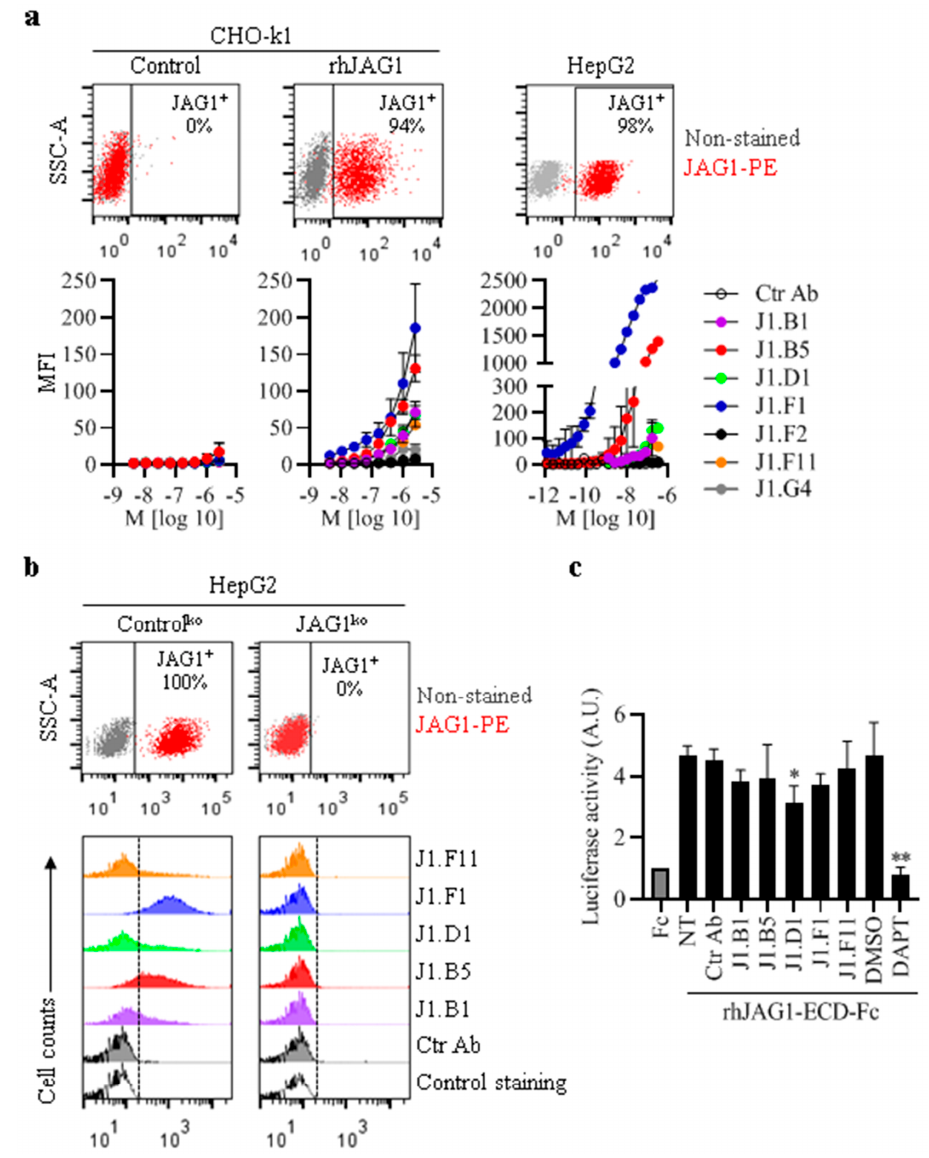
Figure 2. Anti-JAG1 Abs binding ability and specific to cellular human JAG1 and blocking activity. ( a , b ) Flow cytometry analysis showing anti-JAG1 Abs bind exclusively to JAG1-positive cells. ( a ) Dose–response binding of anti-JAG1 Abs or Ctr Ab to CHO-k1 cells overexpressing hJAG1 on the cellular surface (CHO-k1/rhJAG1), CHO-k1 control cells (CHO-k1/control), and HepG2 cells with endogenous JAG1. Graphs show mean fluorescence intensity (MFI) (±SEM) of two independent assays. Upper cytometric plots show JAG1 expression. ( b ) Binding of 2700 nM of anti-JAG1 cell binders identified in ( a ) and Ctr Ab to HepG2 JAG1-positive (HepG2/control ko ) and HepG2 JAG1- negative (HepG2/JAG1 ko ) cells. Control staining indicates cells stained with secondary antihuman IgG (H+L)-A488 alone. ( c ) Effect of anti-JAG1 Abs in JAG1-mediated Notch reporter activation. Cells transfected with the Notch firefly luciferase reporter along with a vector encoding renilla luciferase were cultured in wells precoated with Fc control protein or rhJAG1-ECD-Fc in the absence (NT) or presence of either anti-JAG1 Abs, Ctr Ab (20 μ g/mL each), the pan-Notch inhibitor DAPT (5 μ M), or dimethyl sulfoxide (DMSO, DAPT vehicle). After 36 h, luciferase activities were determined with dual luciferase assay. The graph shows luciferase activity compared with that of cells cultured in the presence of Fc (mean ± SD) from five independent assay, with three or four replicates for each condition. *, p = 0.05 vs. control NT cells; **, p < 0.05 vs. cells treated with DMSO, as determined by two-tailed paired t-test.